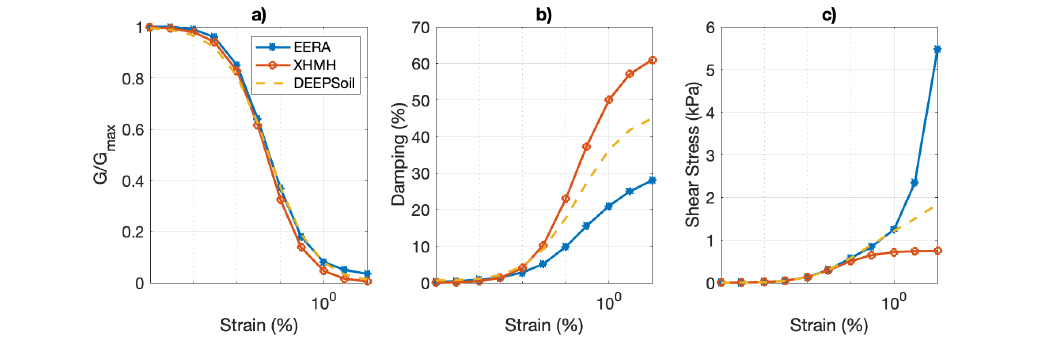
Figure 5. ( a ) Normalized modulus reduction, ( b ) material damping, and ( c ) shear stress curves for the three approaches used in the numerical example for layer